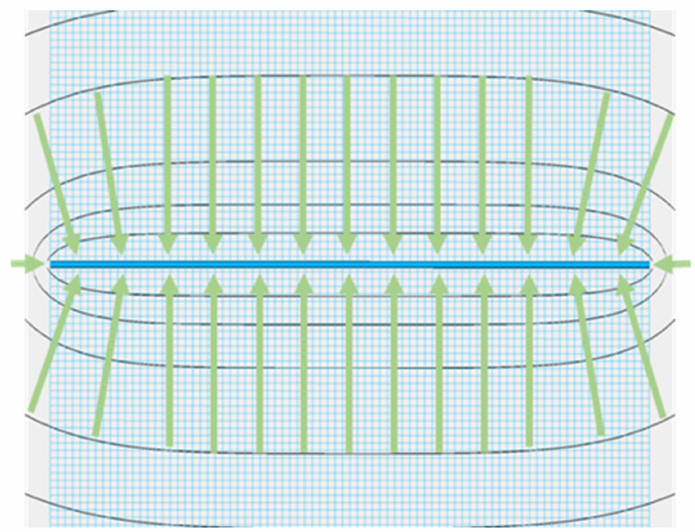
Figure 13. Pressure Iso-line Assumption in Developed Analytical Model for early time semi-linear flow. Equation (18): Elongated Linear Flow